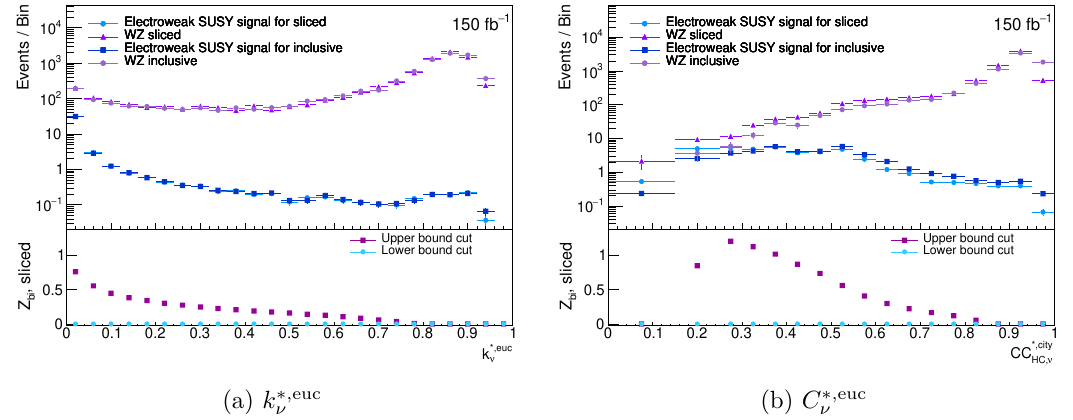
Figure 14. Event rates as functions of k ∗ , euc and CC ∗ , city for the electroweakino simplified model ν HC,ν example, comparing the network variables calculated from inclusive WZ samples with those calcu- lated from WZ samples sliced in p T . Events in the overflow bin are not shown in the distribution but are included in the Z bi calculation. In both cases the SUSY signal sample is the same, and the legend indicates the associated WZ sample its network was built